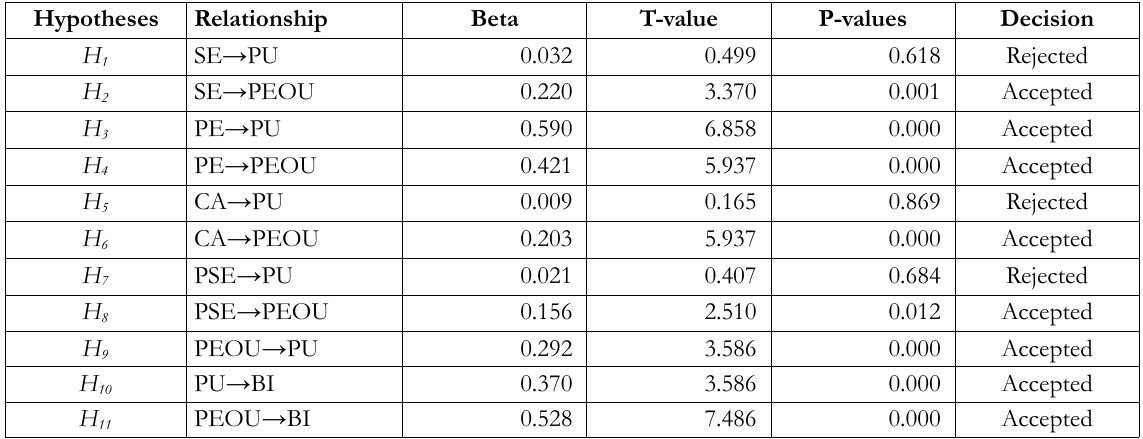
Table 4. Path Coefficients and Results of Hypotheses Testing